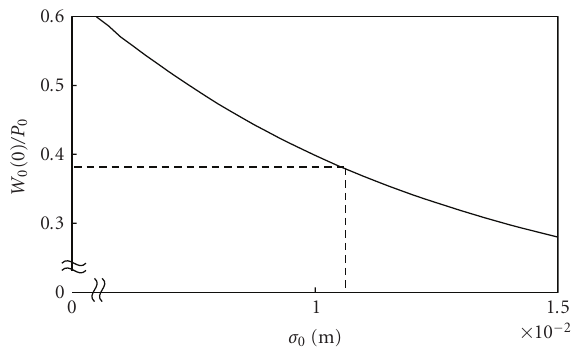
Figure 10: Theoretical variation of W 0 (0) /P 0 with σ 0 and determi- nation of the experimental value of σ 0 .